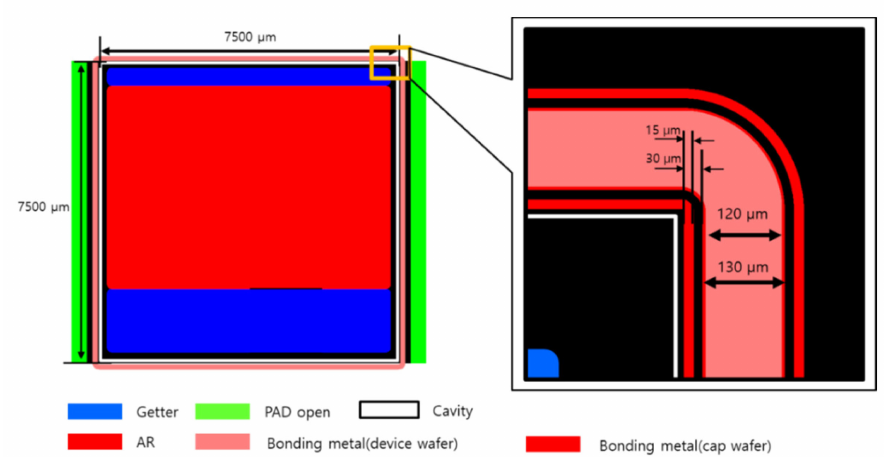
Figure 2. Single die layout of microbolometer cap wafer and enlarged WLP area. Layer colors are the same as in Figure 1.